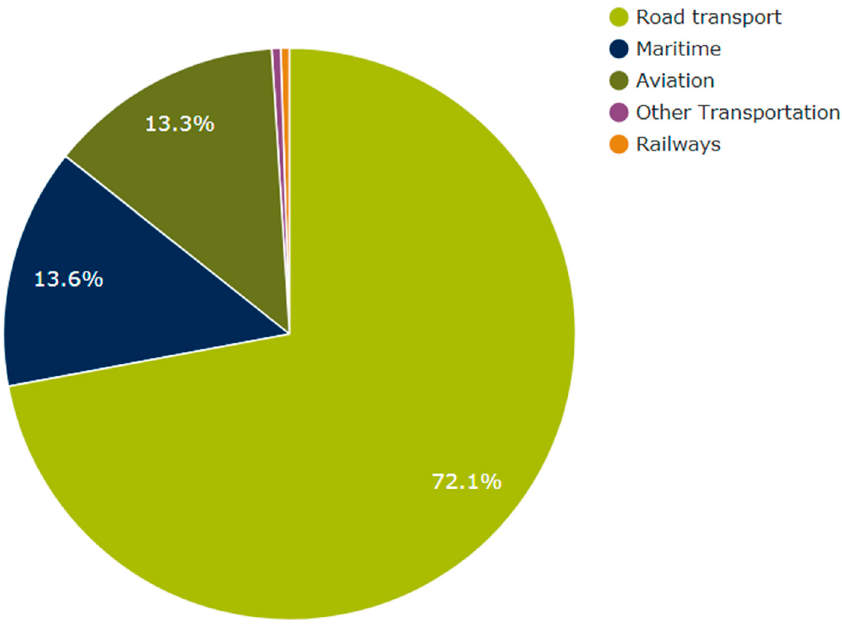
Figure 16. CO 2 emissions for different types of transport, source [23].